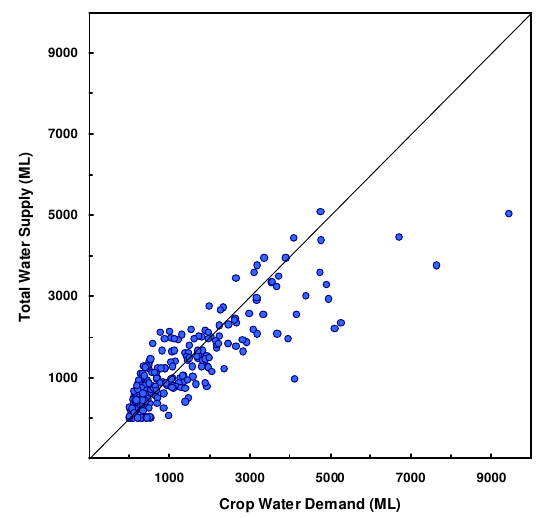
Figure 3. Crop water requirement vs water supply in Goulburn- Murray catchment during January – April 2009. The line shows the relationship, TWS = CWR, where farm water supply and water demand are in approximate